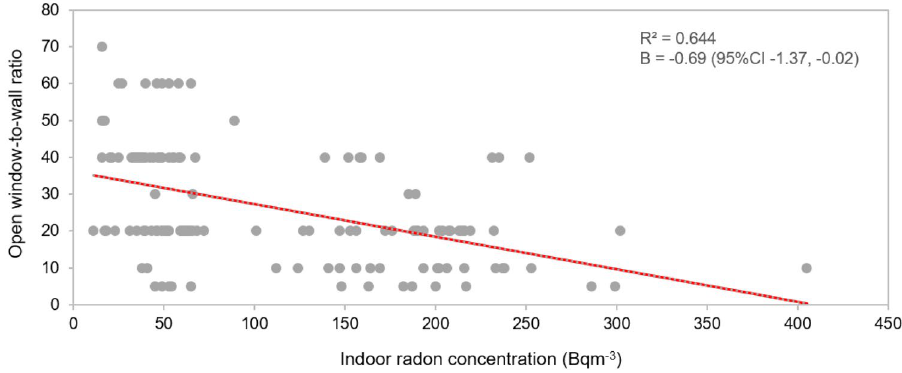
Figure 2. The association between open window-to-wall ratios and indoor radon concentrations in participant bedrooms.